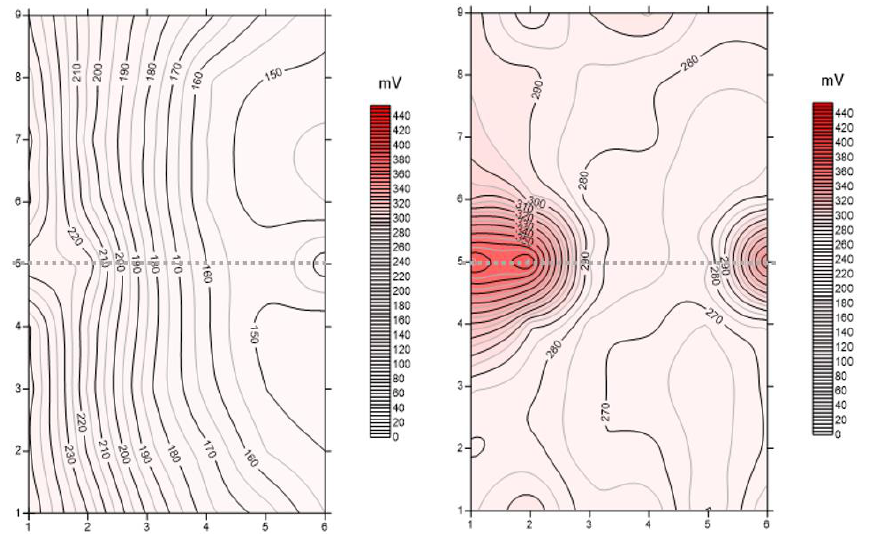
Figure 14. Self-potential maps were obtained on the concrete sample. The map shown on the left was realized the day before starting the accelerated corrosion tests on the sample. The map on the right was obtained after 10 days of accelerated corrosion testing.